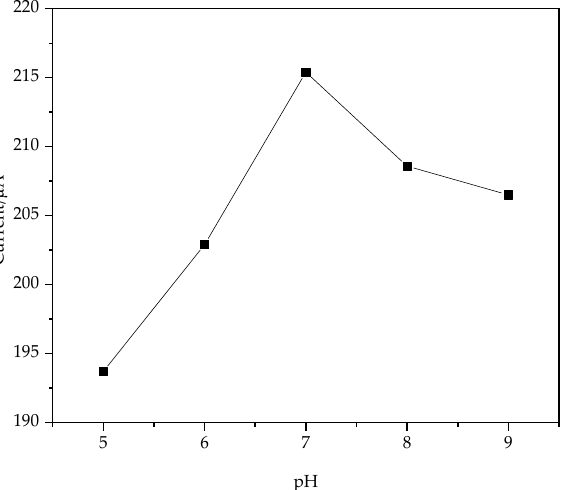
Figure 6. CV of AuNPs/MXene/ERGO/GCE in 0.1 M PBS containing 3 mM nitrite at different pH values (pH = 5, 6, 7, 8, 9), scan rate = 50 mV/s.